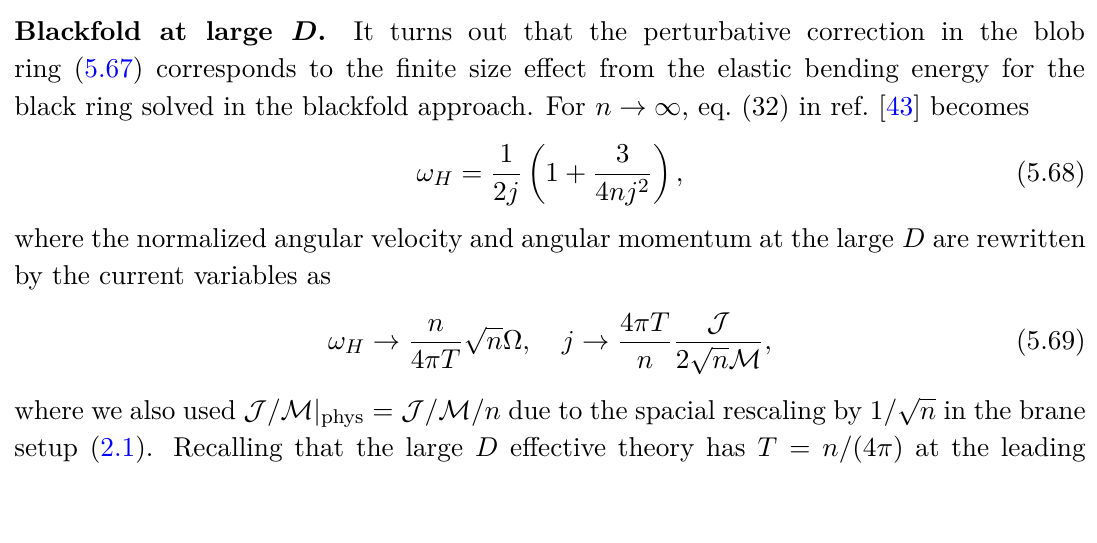
(cid:0) (cid:1) Ω 10 as in eq. (B.2), so that the expansion is